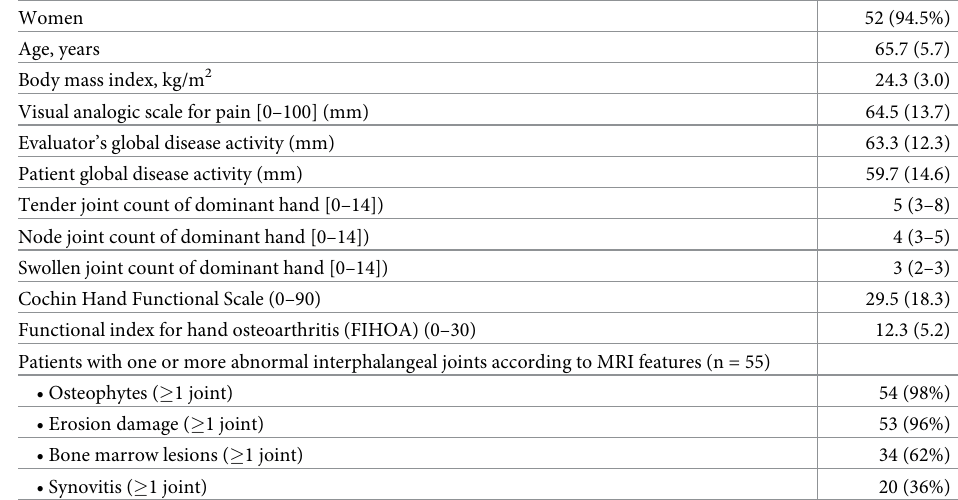
Table 1. Baseline demographic and clinical characteristics (n =